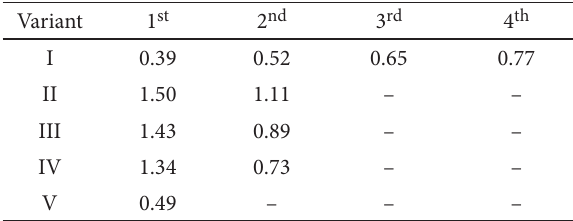
table 5. Sorted by zones (1 st , 2 nd , 3 rd and 4 th ) values, MN/m 3 , of deformable soil bed between the raft and soil